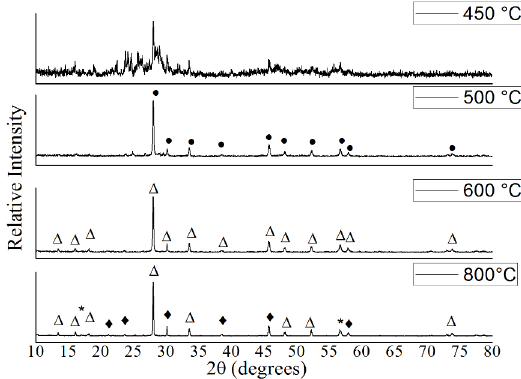
Figure 2. X-ray diffraction patterns of cerium molybdate powders. Symbols legend: ●- tetragonal Ce ♦- Ce O , *- Ce O 11 20 7 12